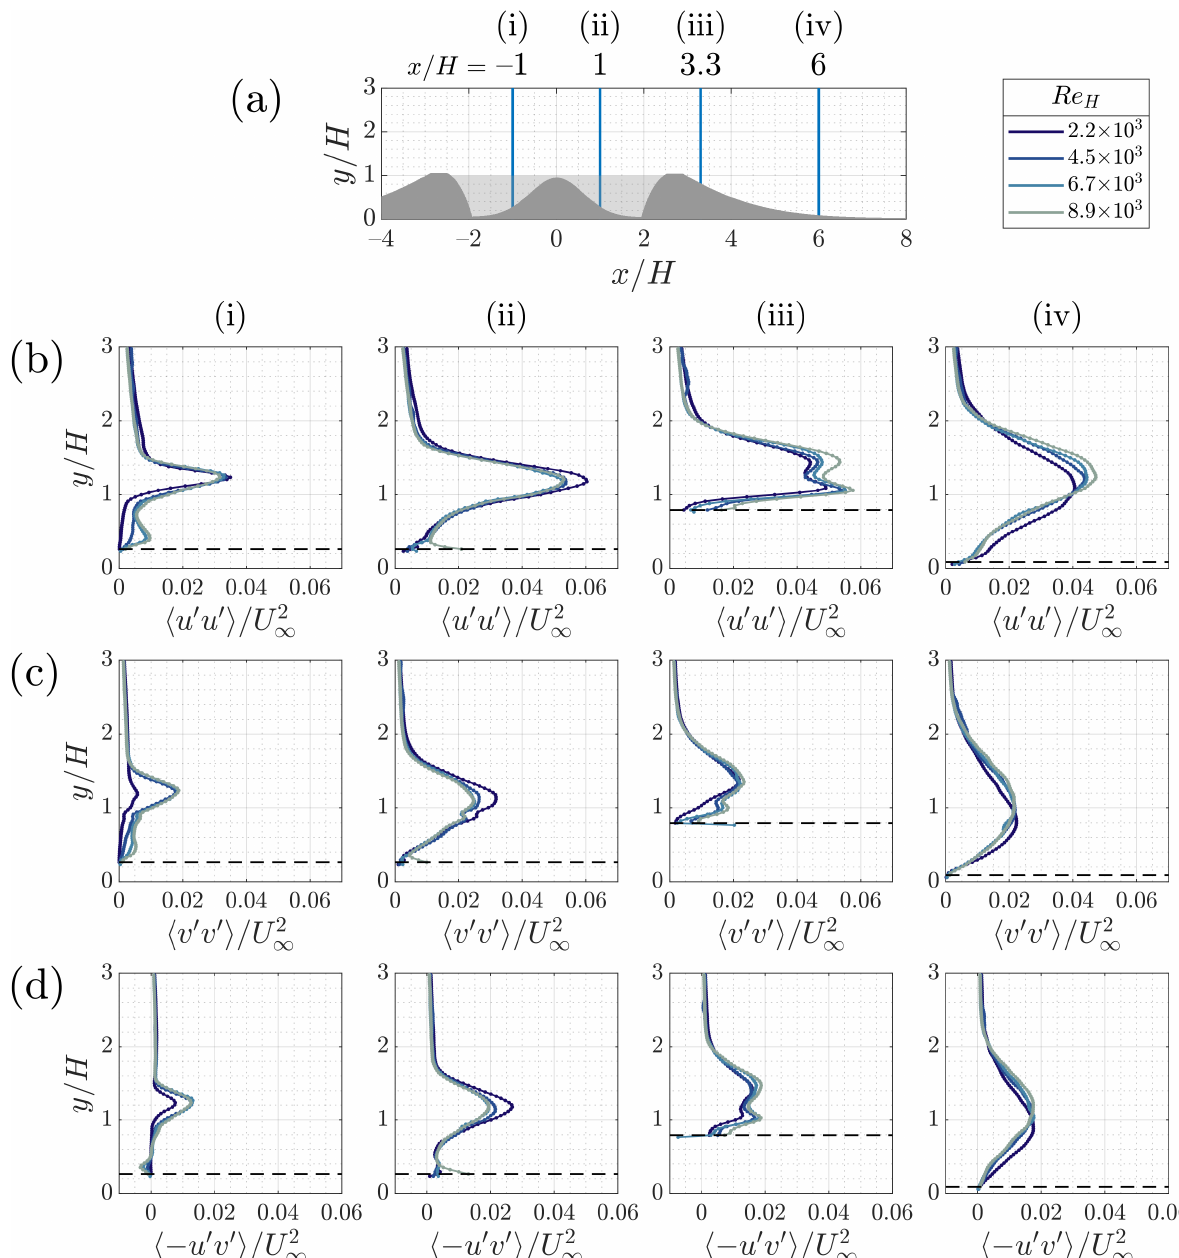
Figure 6. Normalized profiles of Reynolds stresses along the crater centerline for four different Re . ( a ) A reference for the streamwise locations of the profiles; ( b ) streamwise stresses, (cid:104) u (cid:48) u (cid:48) (cid:105) / U 2 ∞ ; ( c ) wall-normal stresses, (cid:104) v (cid:48) v (cid:48) (cid:105) / U 2 ∞ ; ( d ) shear stresses, (cid:104)− u (cid:48) v (cid:48) (cid:105) / U 2 ∞ . The horizontal dashed lines in ( b , c ) demarcate the elevations of the model’s surface at the corresponding x / H = profile